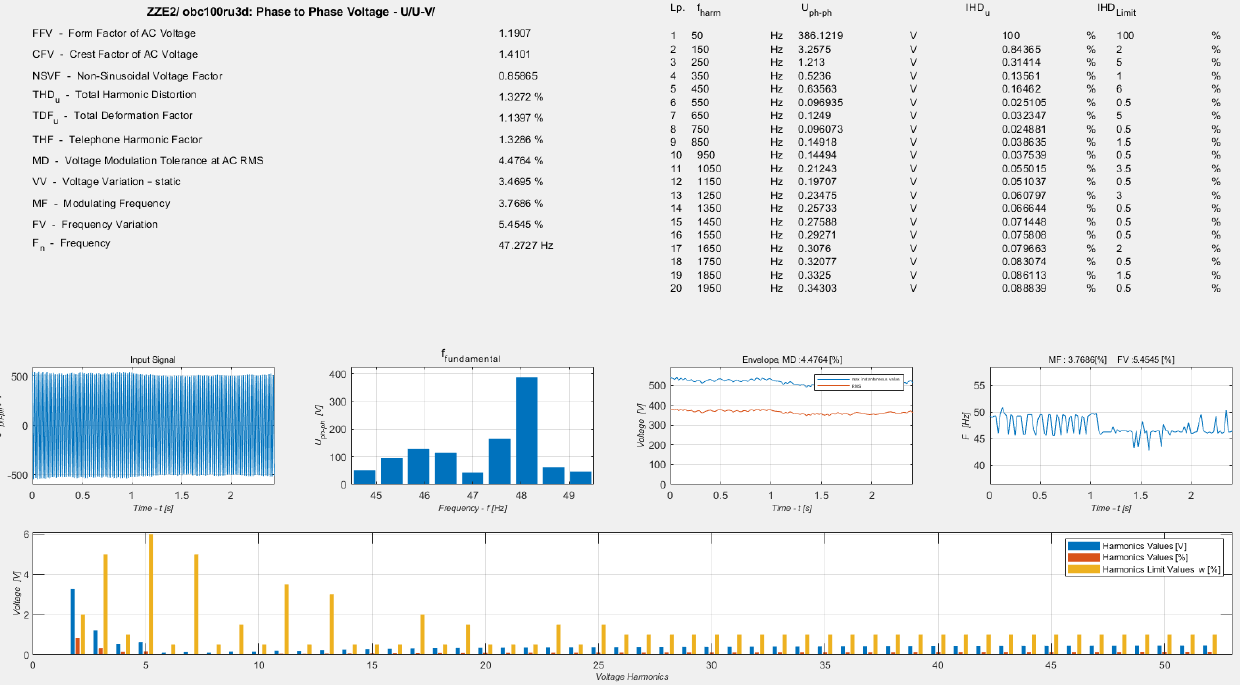
Figure 6. The MATLAB user interface of the ELPAR application: a set of analyses for synchronous generator armature voltages.